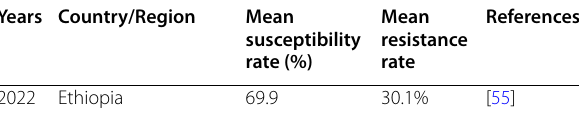
Table 3 Mean susceptibility and resistance rates in ophthalmic bacterial infections from reviewed